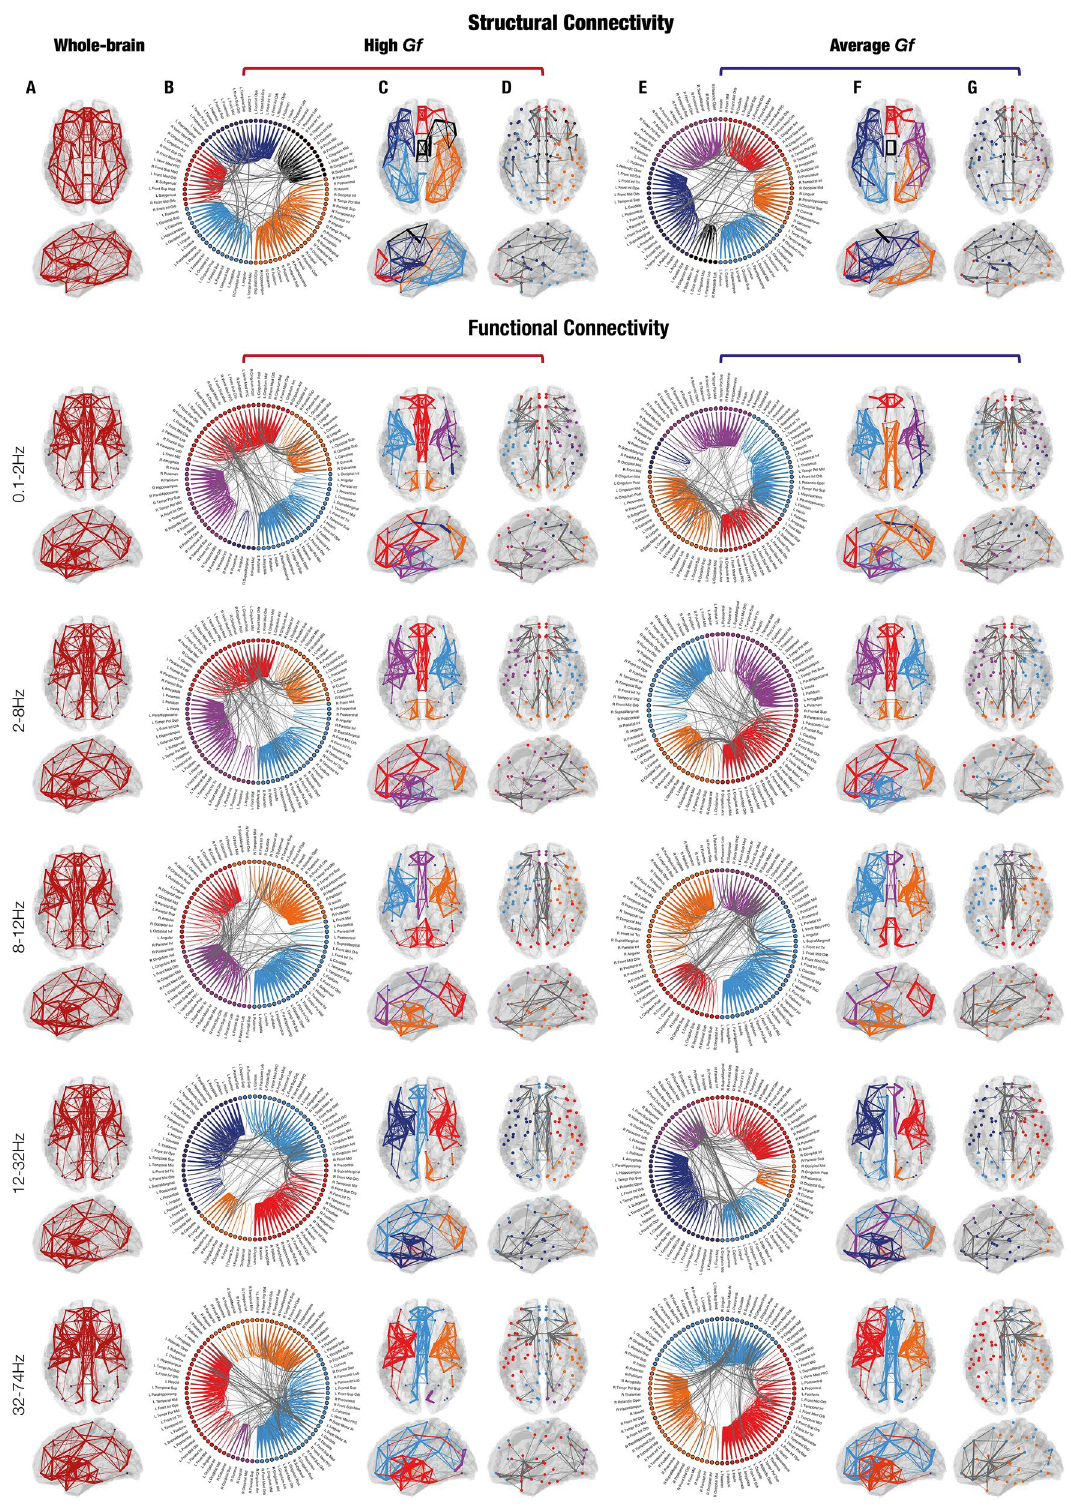
Figure 5. Inter and Intra-module connectivity in high versus average Gf. ( A ) Whole-brain structural and functional connectivity in all participants. ( B ) Circular connectogram representing inter- (in gray) and intra-module (different colors) connections in high Gf participants. ( C ) Brain modules and intra-module connections overlaid on a standard brain template, in individuals with high Gf. Different modules are represented by edges with different colors. ( D ) Inter-module connections in individuals with high Gf. Different modules are represented by dots in different colors, while inter-module connections are represented by grey edges. ( E ) Circular connectogram representing inter- (in gray) and intra-module (different colors) connections in average Gf participants. ( F ) Brain modules and intra-module connections in individuals with average Gf. Different modules are represented by edges with different colors. ( G ) Inter-module connections in individuals with average Gf. Different modules are represented by dots in different colors, while inter-module connections are represented by grey